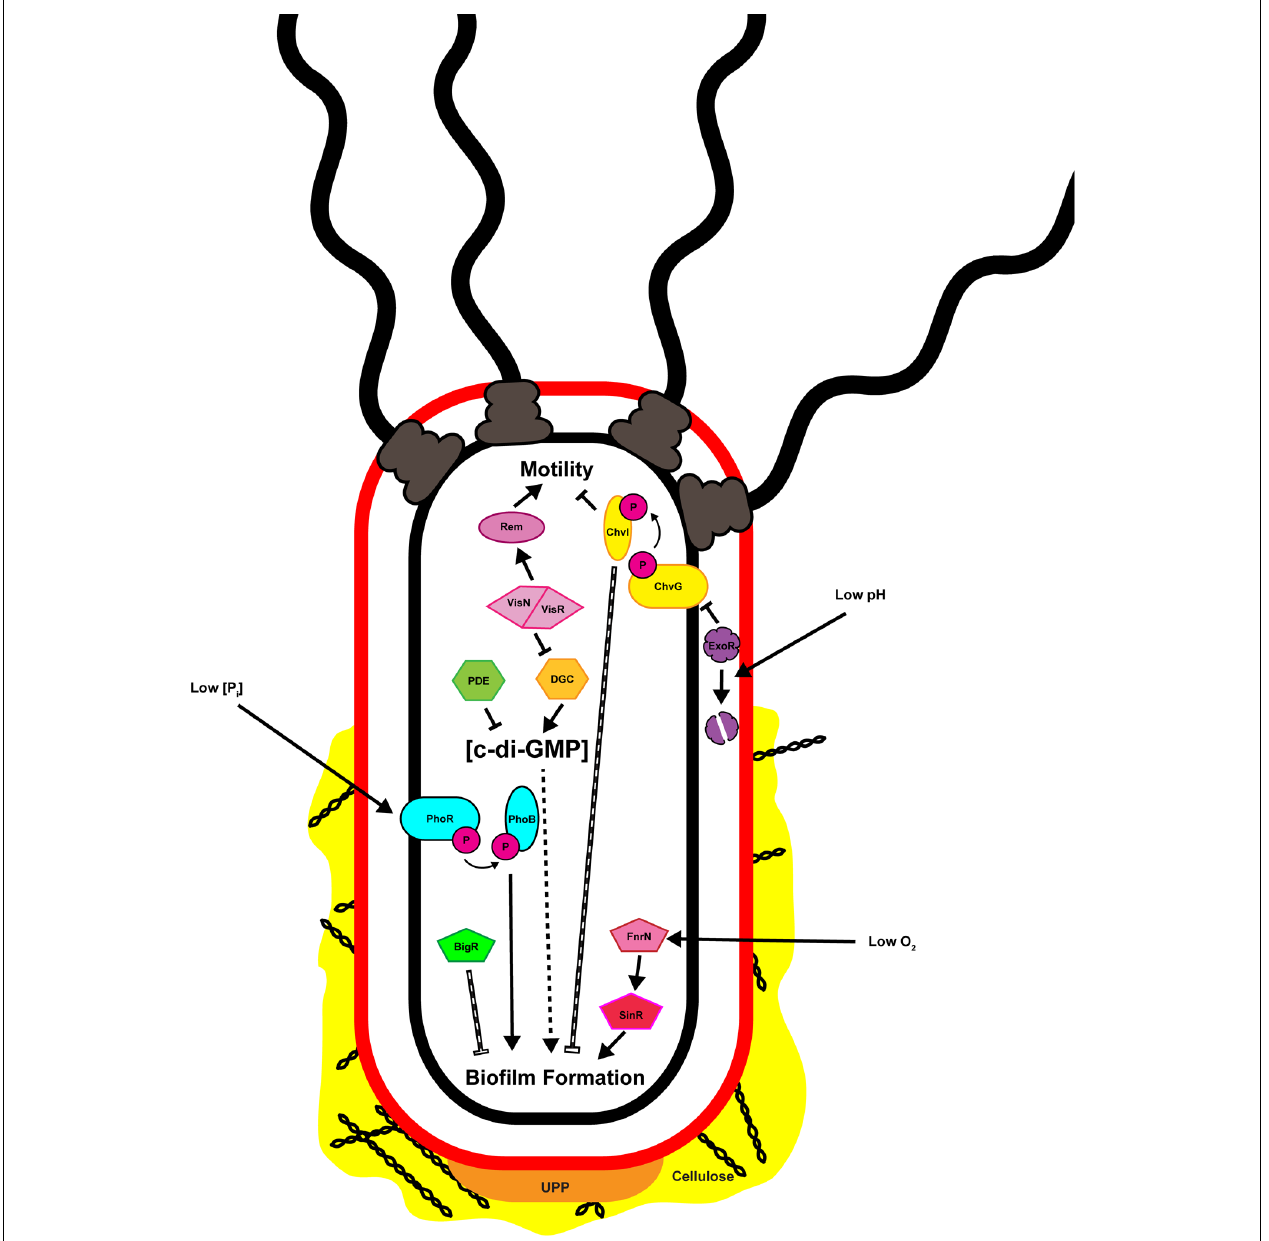
FIGURE 2 | Multiple inputs regulate attachment and biofilm formation by Agrobacterium tumefaciens . Depicted in the image are the known factors regulating attachment and biofilm formation and discussed in the text. Solid black arrows and bars indicate direct positive or negative regulation,